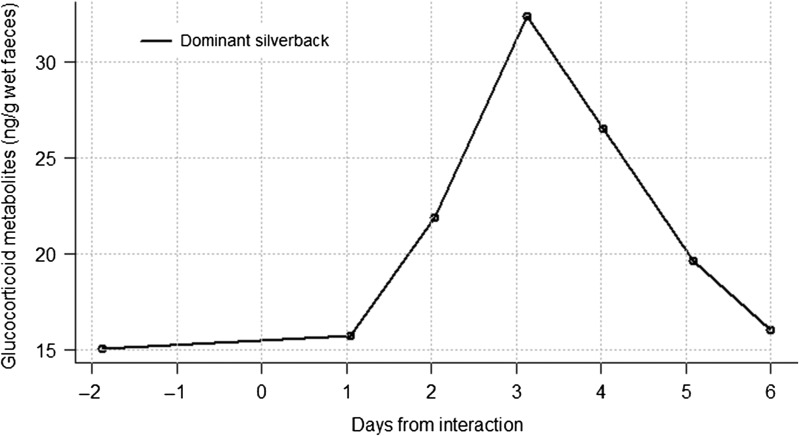
Faecal glucocorticoid metabolite concentration profile of the dominant silverback from Kuryama group before and after an interaction with a solitary silverback.